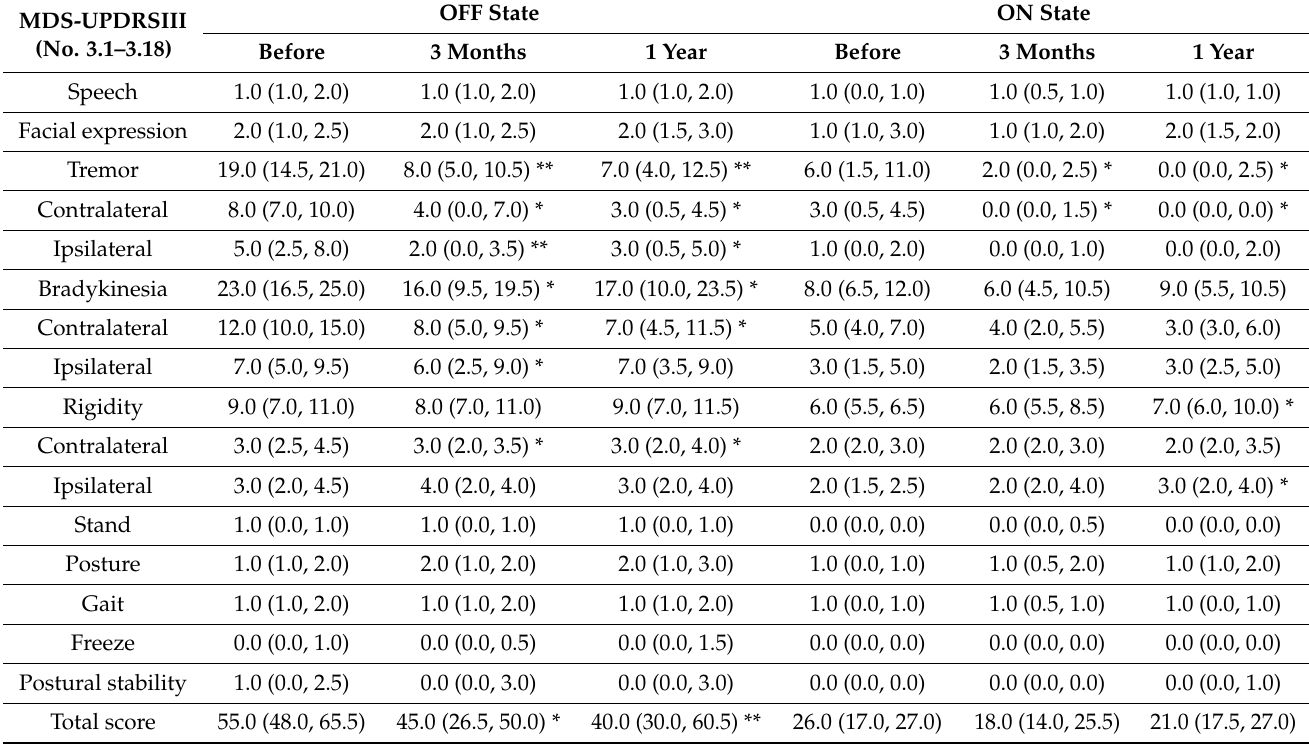
Table 2. Comparison of MDS-UPDRSIII scores during operation with before operation.